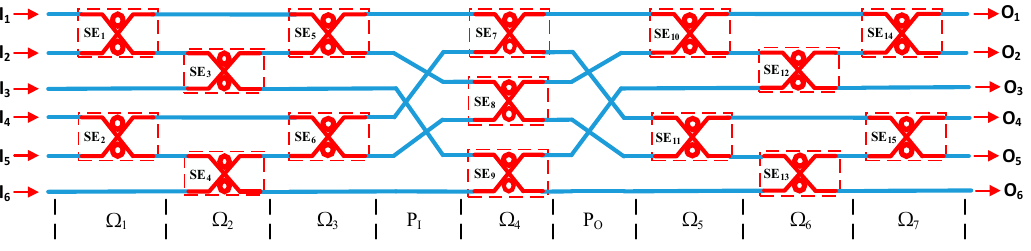
Figure 2. 6 × 6 HCROS Optical switch architecture with 15 OSEs .